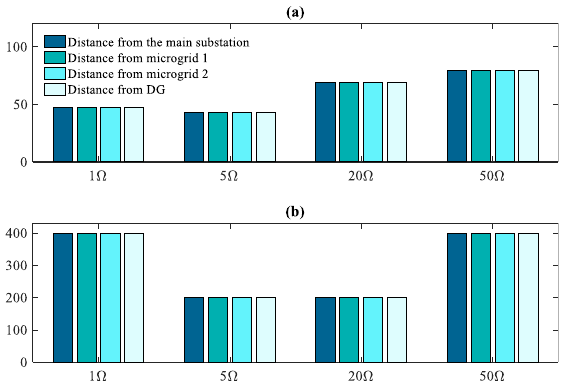
Fig. 12 Output errors of the KNN for different fault resistances using non-synchronized measurements for 424 test cases. a MAE b